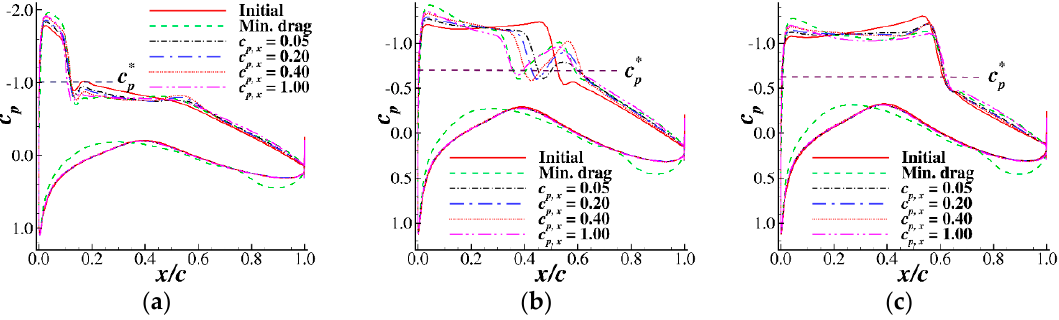
Figure 16. Pressure distributions at different Mach numbers ( Re = 6.5 × 10 6 , C L = 0.800). ( a ) Ma = 0.65; ( b ) Ma = 0.72; and ( c ) Ma = 0.74.